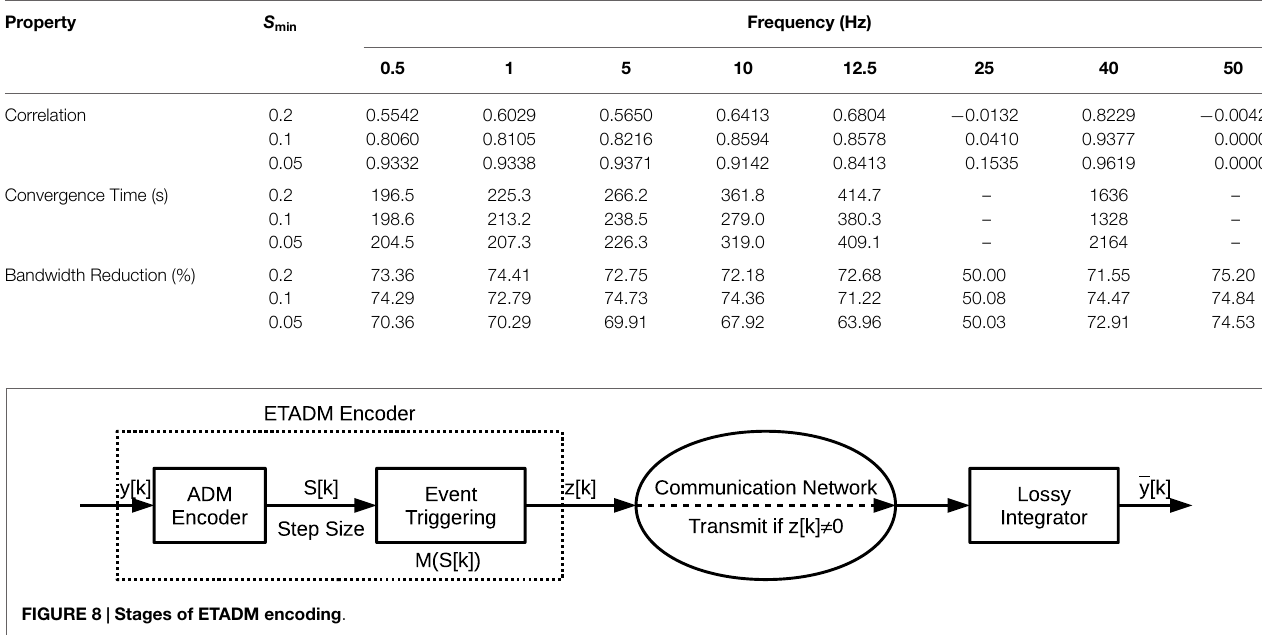
TABLE 2 | ETADM performance results (correlation, convergence, and bandwidth reduction) .